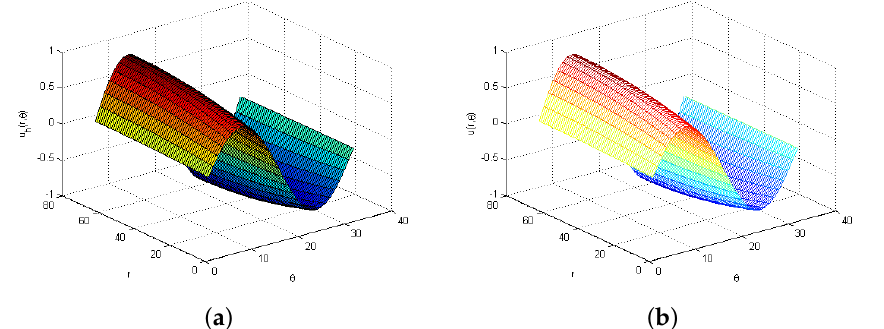
Figure 4. Numerical solution y f